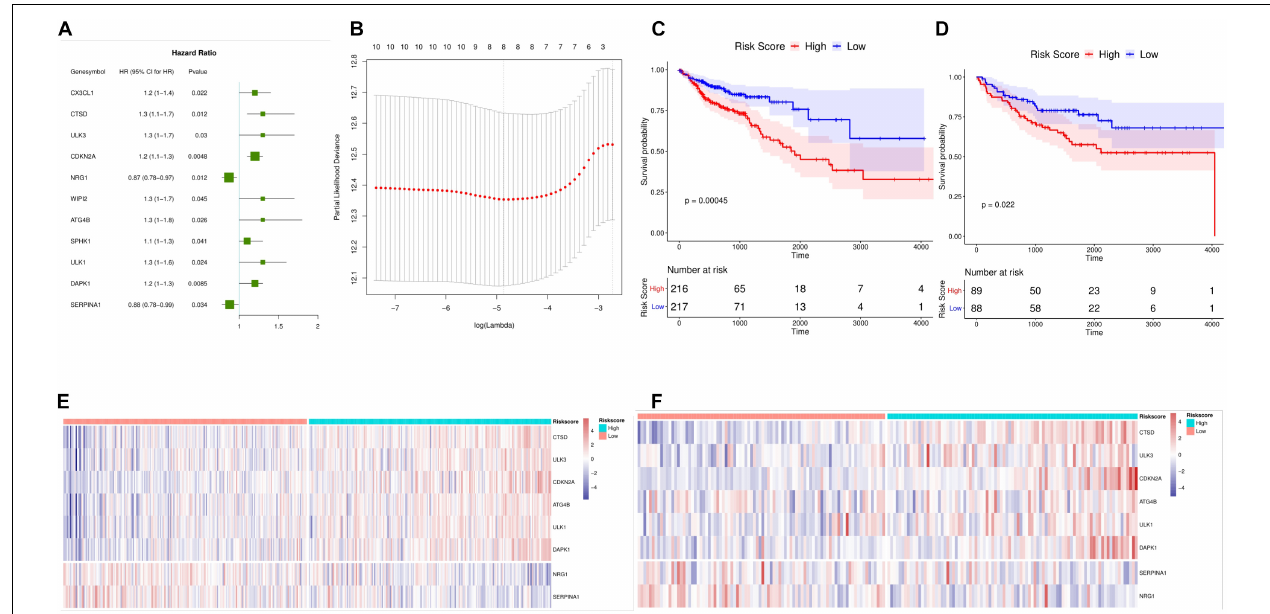
FIGURE 3 | Establishment of a prognostic model for colon cancer. (A) Forest maps of 15 autophagy genes significantly associated with colon cancer prognosis. HR Hazard ratio, 95%CI 95% confidence interval. (B) LASSO Figure in the regression model to determine the tuning parameter lambda. the horizontal axis is log (lambda), and the longitudinal axis is the partial likelihood deviation value (partial likelihood Deviance). the corresponding Lambda value at the minimum of this value is the best, that is, the best Lambda value after taking the Log below the dotted line, and the number of variables corresponding above. (C) Survival curve Kaplan Meier TCGA data set, the horizontal axis is time, the longitudinal axis is survival, and different colors represent different groups. P -values are based on log-rank tests. (D) Kaplan Meier survival curve and time dependent ROC curve of (GEO) datasets. (E,F) Heat maps of mRNA expression of eight selected genes in high and low risk score samples of TCGA and GEO datasets. The horizontal axis is the sample, the longitudinal axis is the gene, the red represents the high expression, the blue represents the low expression, and the heat map shows the category of the sample with different colors